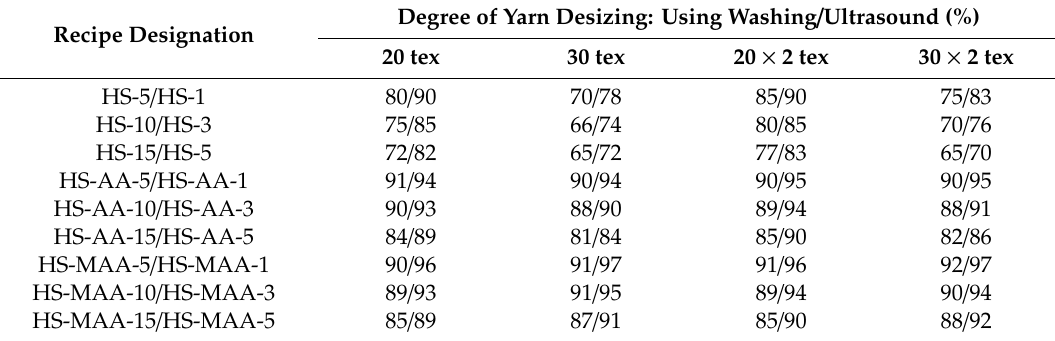
Table 8. Degree of yarn desizing by using washing / ultrasound o ff .